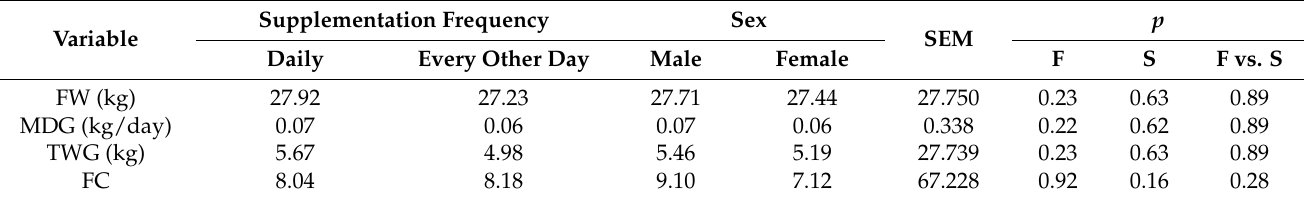
Table 3. Performance of sheep submitted to intermittent supplementation on Masai grass pasture.